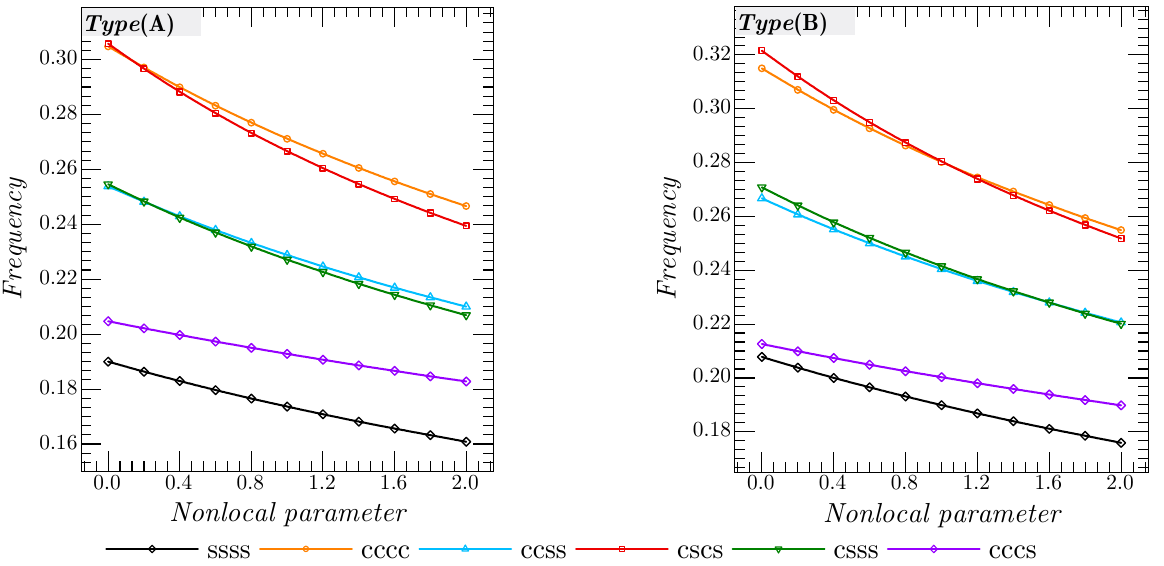
Figure 10. Effect of nonlocal parameter on the dimensionless frequency of spherical shell for various boundary conditions ( FG − X , N = 10, V ∗ cnt = 0.17, p = 1, λ = 0 ) .